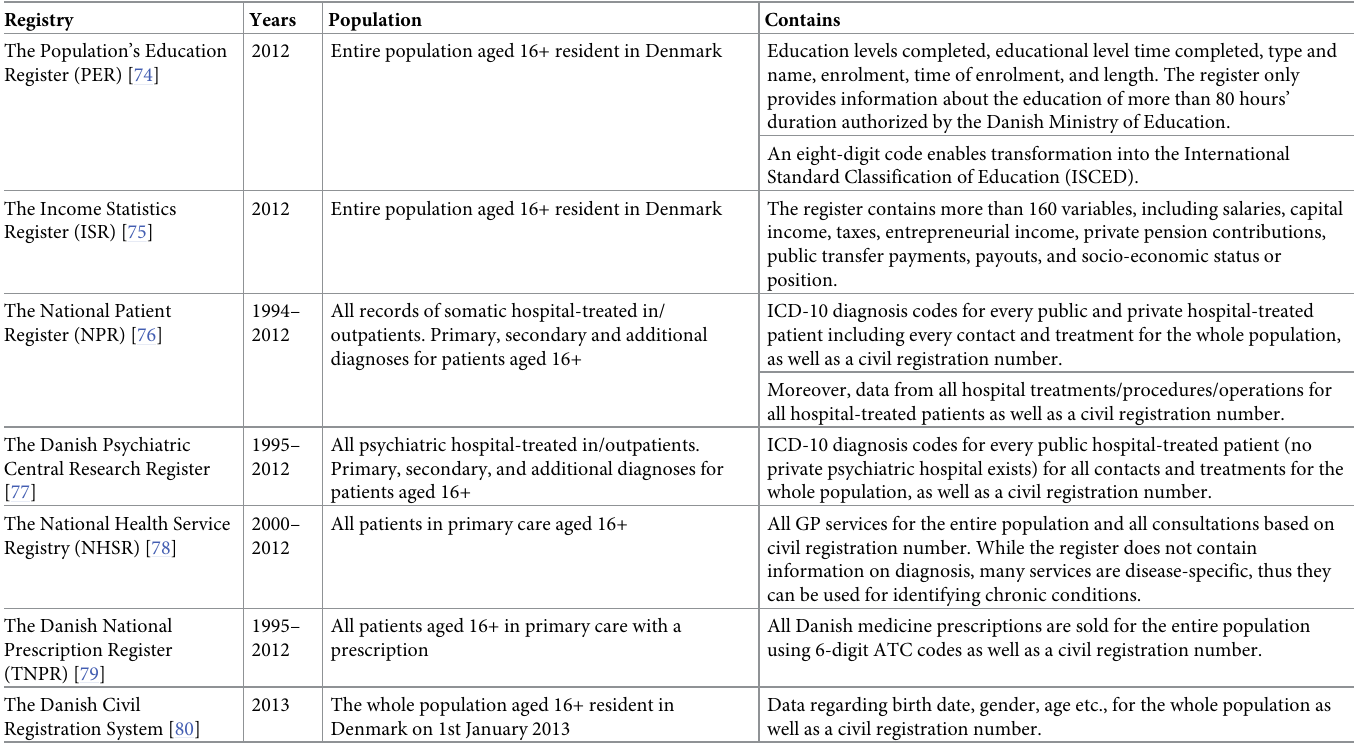
Table 1. Summary of the registers used and characteristics of the selected